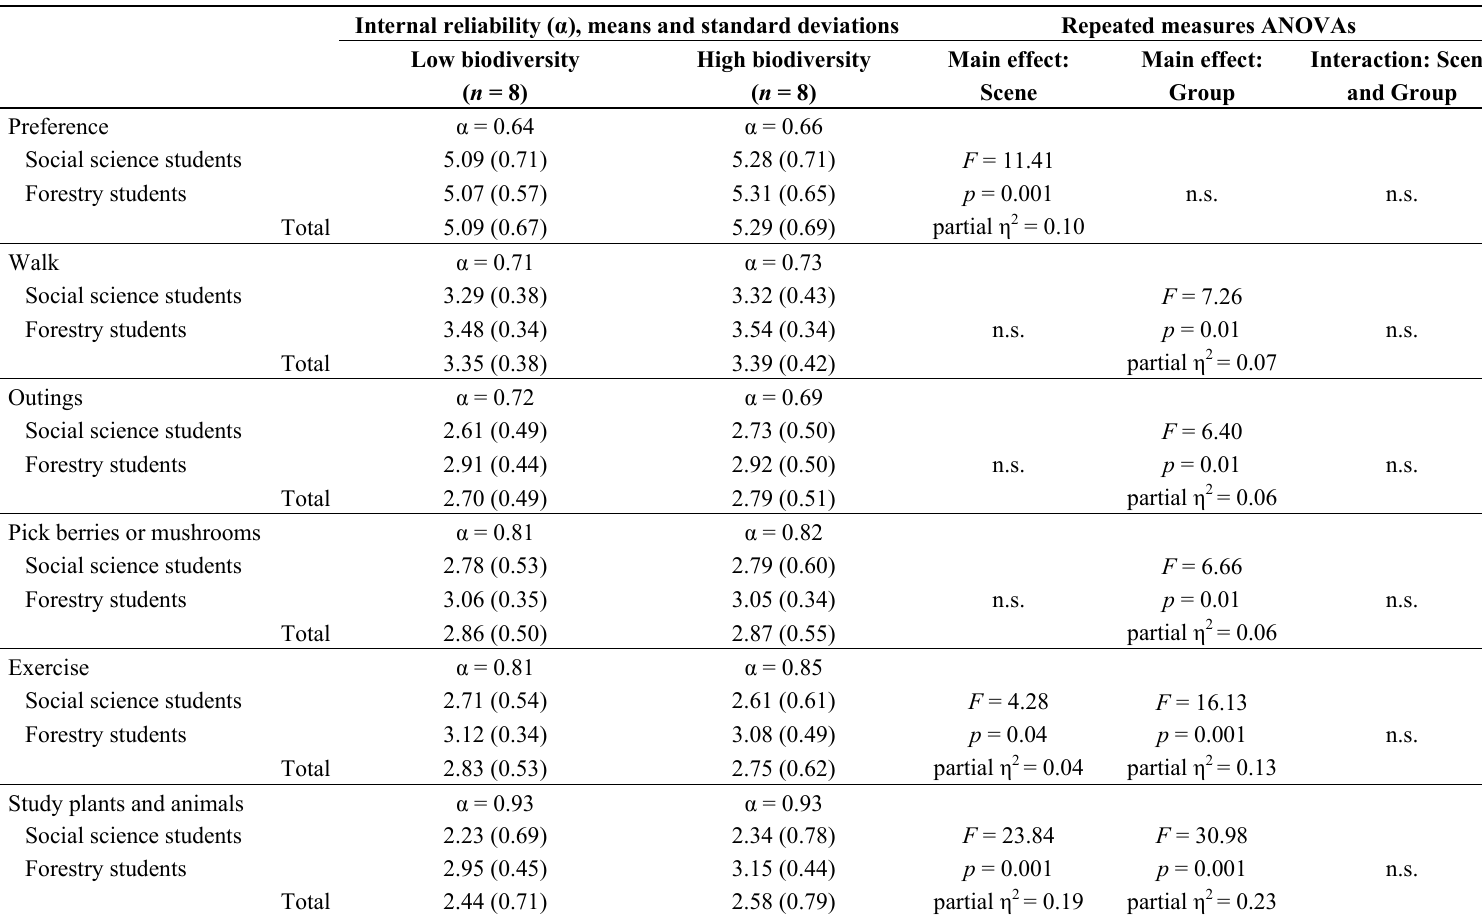
Table 4. Internal reliability ( α ), means, standard deviations, and results from the repeated measures ANOVAs in relation to preference and intention to engage in activities in settings with low and high levels of biodiversity among the social science and forestry